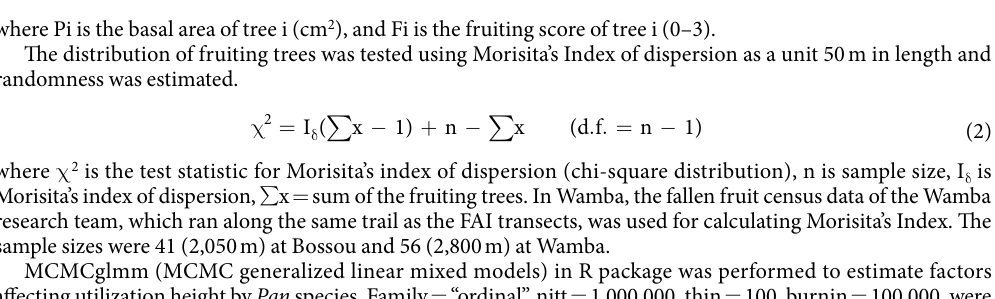
749 at Bossou and 104 at Wamba. Fruit abundance for each tree was ranked on a relative scale from 0–3, and FAI (fruit availability index (%)) was calculated, with the FAI when all trees were fully fruited (scale of 3) taken as 100%, as follows